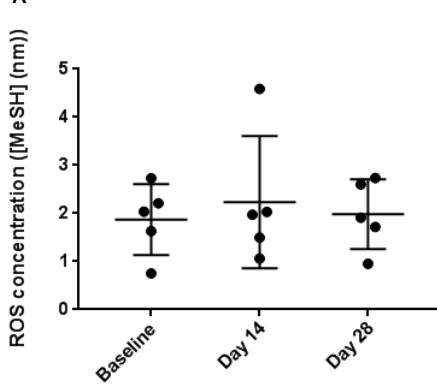
Figure 4. Faecal reactive oxygen species (ROS) concentrations at baseline, day 14 and day 28 of the intervention. No significant changes were observed (1way ANOVA with p < 0.05) across all time points.